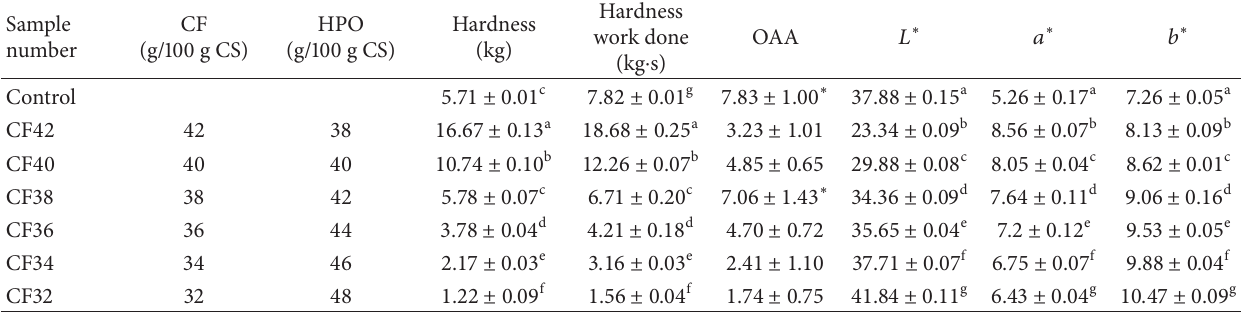
Table 4: Instrumental spreadability, sensory, and colour values of the formulations.